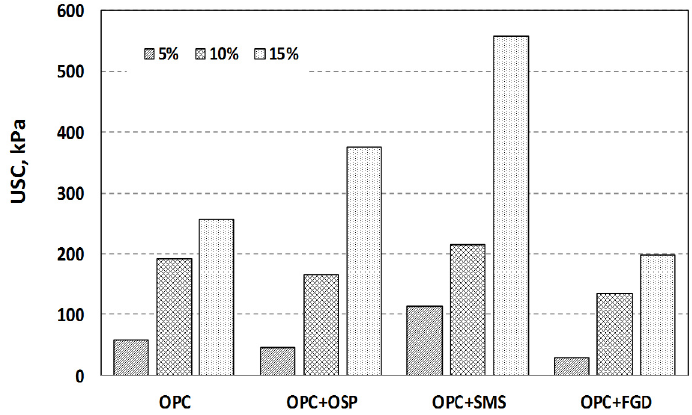
Figure 5. UCS with mixture with type of admixtures at 28 curing days.